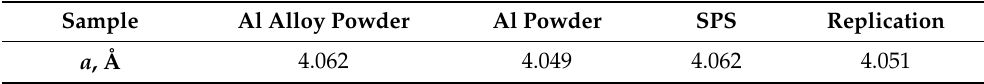
Table 3. Unit cell parameters were obtained by the Le Bail